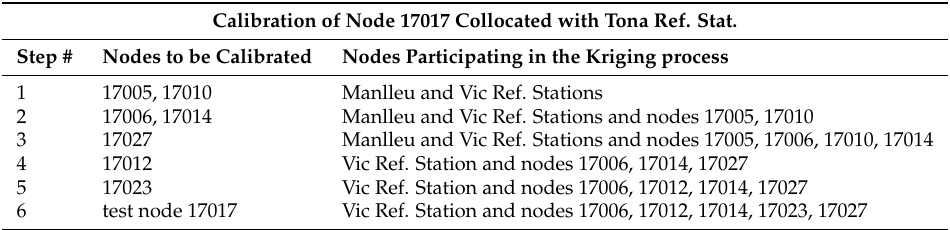
Table 7. Multi-scale calibration with Kriging estimates (Captor node